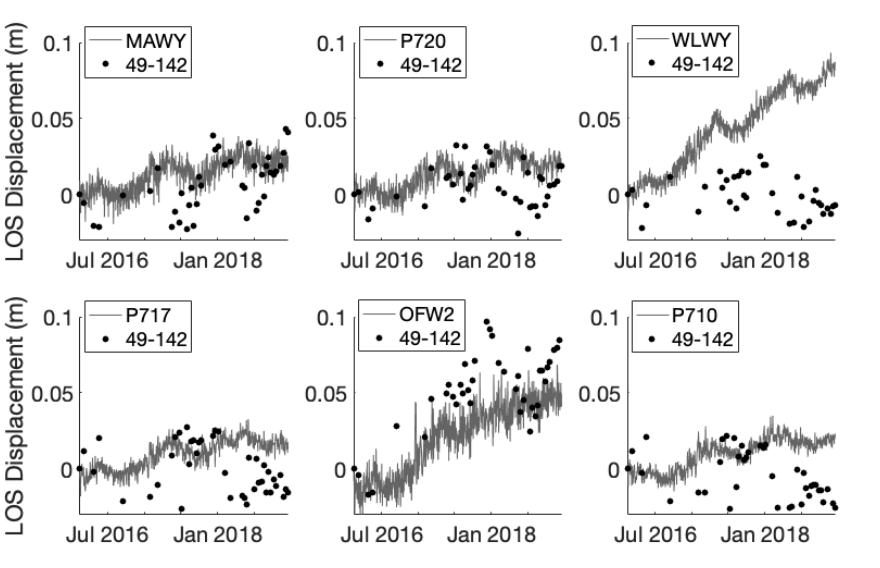
Figure 12. Comparison of GNSS displacement with displacement derived from the corresponding DInSAR pixel in the 49-142 frame. The displacements are shown in the LOS direction of the DInSAR data acquisition.